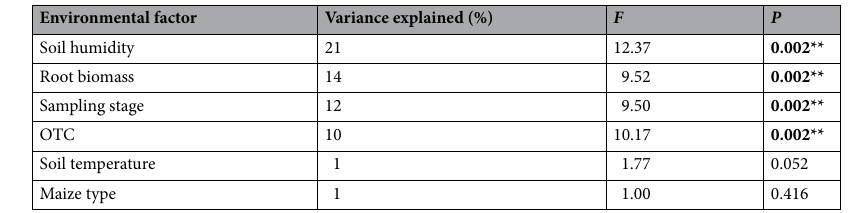
Table 3. Effects of soil humidity, root biomass, sampling stage, soil temperature and maize type on the soil Collembola in a Monte Carlo redundancy analysis (RDA) test. The values highlighted in bold are statistically significant (** P <